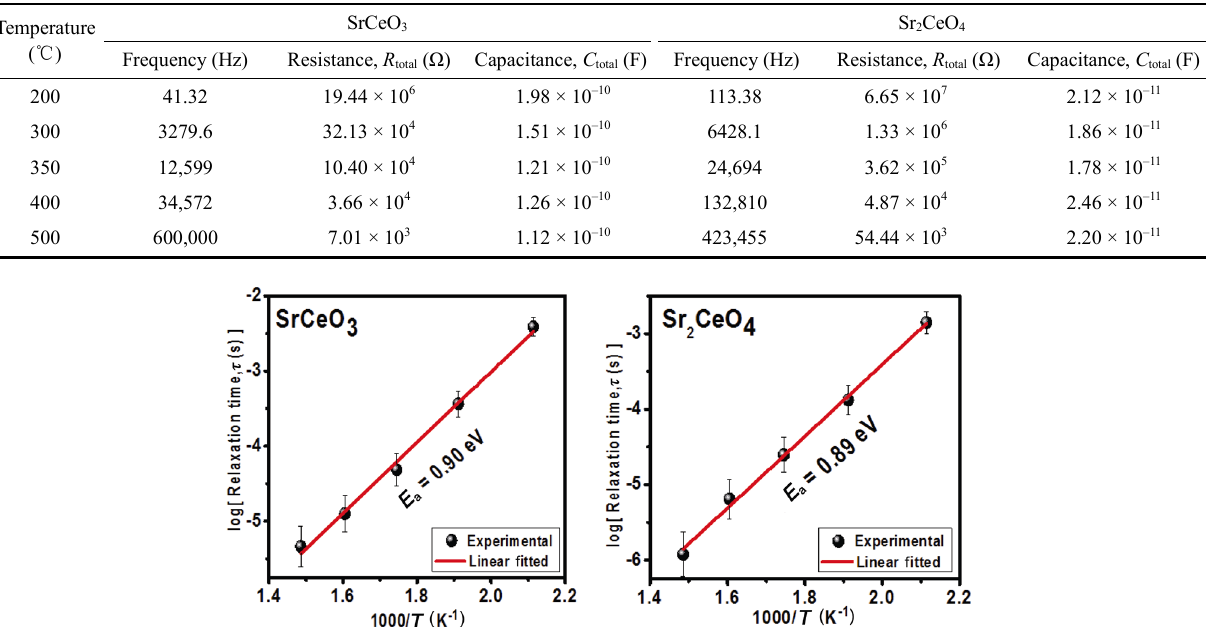
Table 2 Values of relaxation frequency, resistance, and capacitance evaluated from Z ʺ vs. log f plots